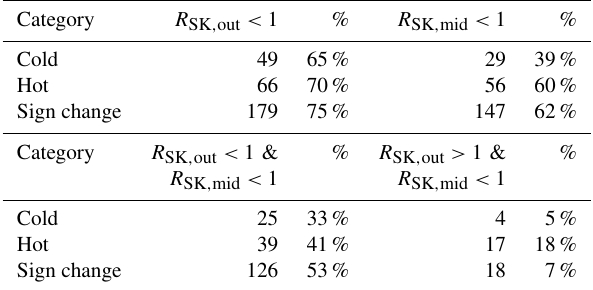
Table 2. Top: numbers and percentages of MM-stable conditions outside and inside of the LMHs per category. Bottom: numbers and percentages of MM-stable LMHs in stable outside plasma and of MM-stable LMHs in unstable outside